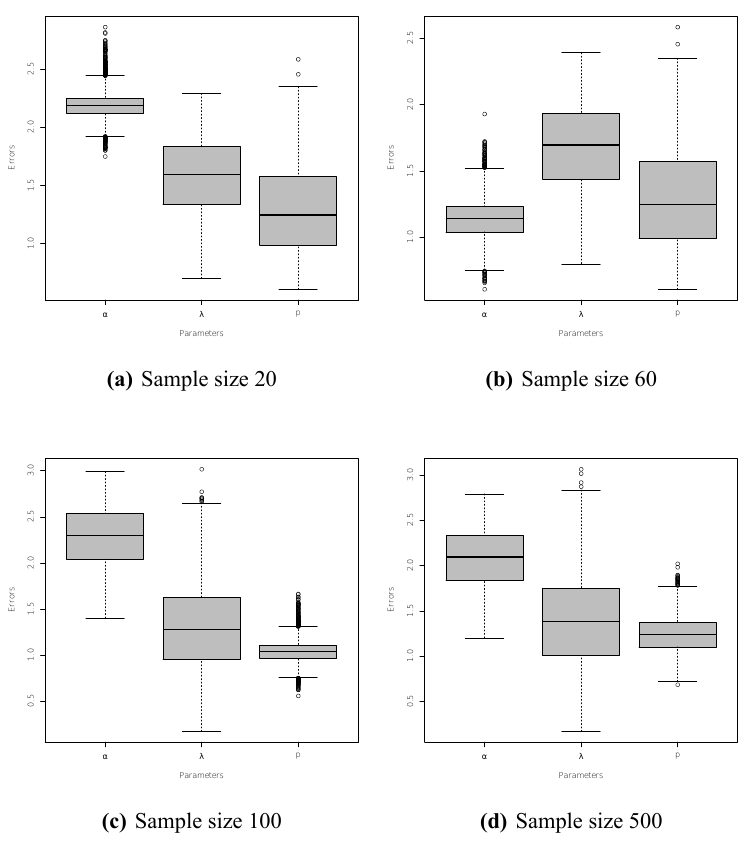
Figure 4 - Errors evaluated by bootstrap and the maximum likelihood using the PSO method with 500 bootstrap